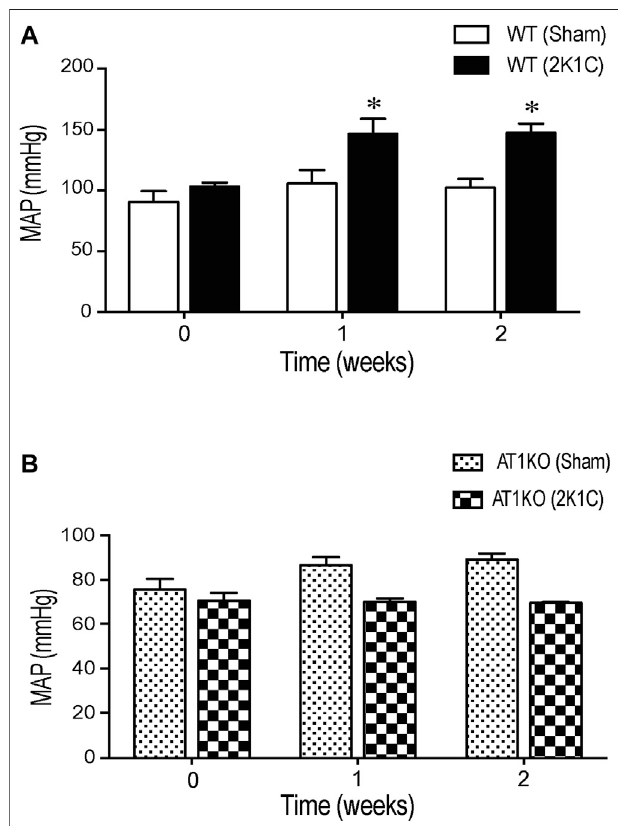
FIGURE1| Effectof2K1CGoldblattsurgeryon24 hmeanarterialblood pressure in angiotensin-II (Ang-II) type 1 A receptors wild type (WT) and angiotensin-II (Ang-II) type 1 A receptors knock out (AT1KO) mice. Mean arterial pressure was measured at base line (0 weeks), 1 and 2 weeks following 2K1C surgery in (A) WT (sham) and WT (2K1C) (B) AT1KO (sham) and AT1KO (2K1C). ANOVA showed a signi fi cant increase of MAP in WT 2K1C mice compared to baseline (0 weeks) and WT sham mice during the 2 weeks of the study (* p < 0.05 vs. Sham). Data are represented as mean ± SEM, (n (cid:2) 6 – 8).